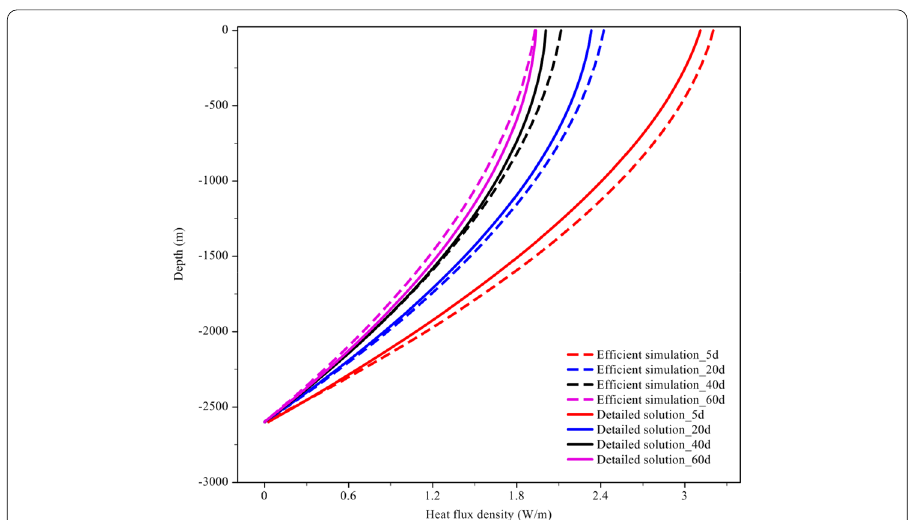
Fig. 13 Comparison of simulation results of heat flux loss between annulus and inner pipe due to thermal short-circuiting with depth during the heating